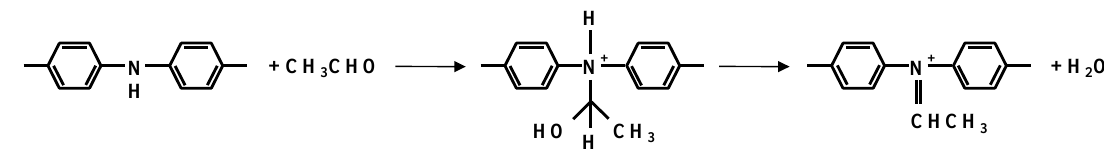
Figure 15. Suggested reaction of acetaldehyde with